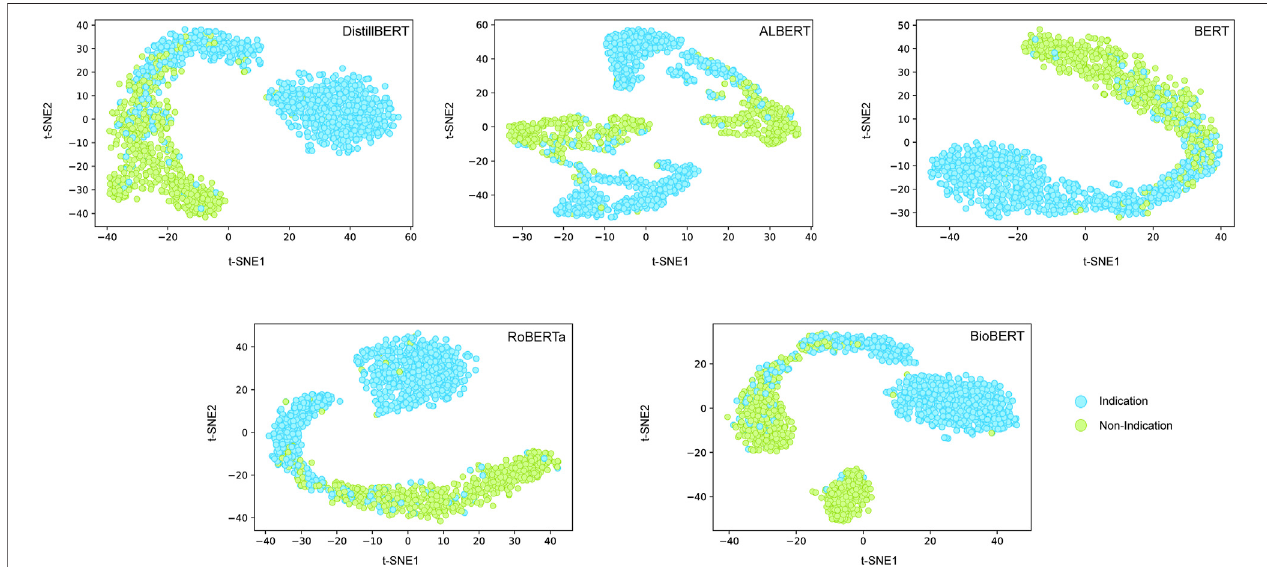
FIGURE 4 | t-SNE analysis of average hidden states of transformers on test